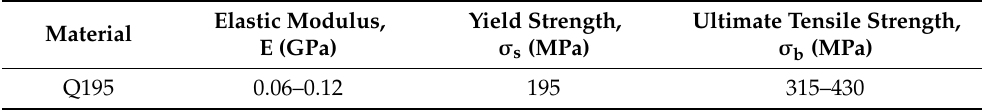
Table 2. Mechanical properties of Q195